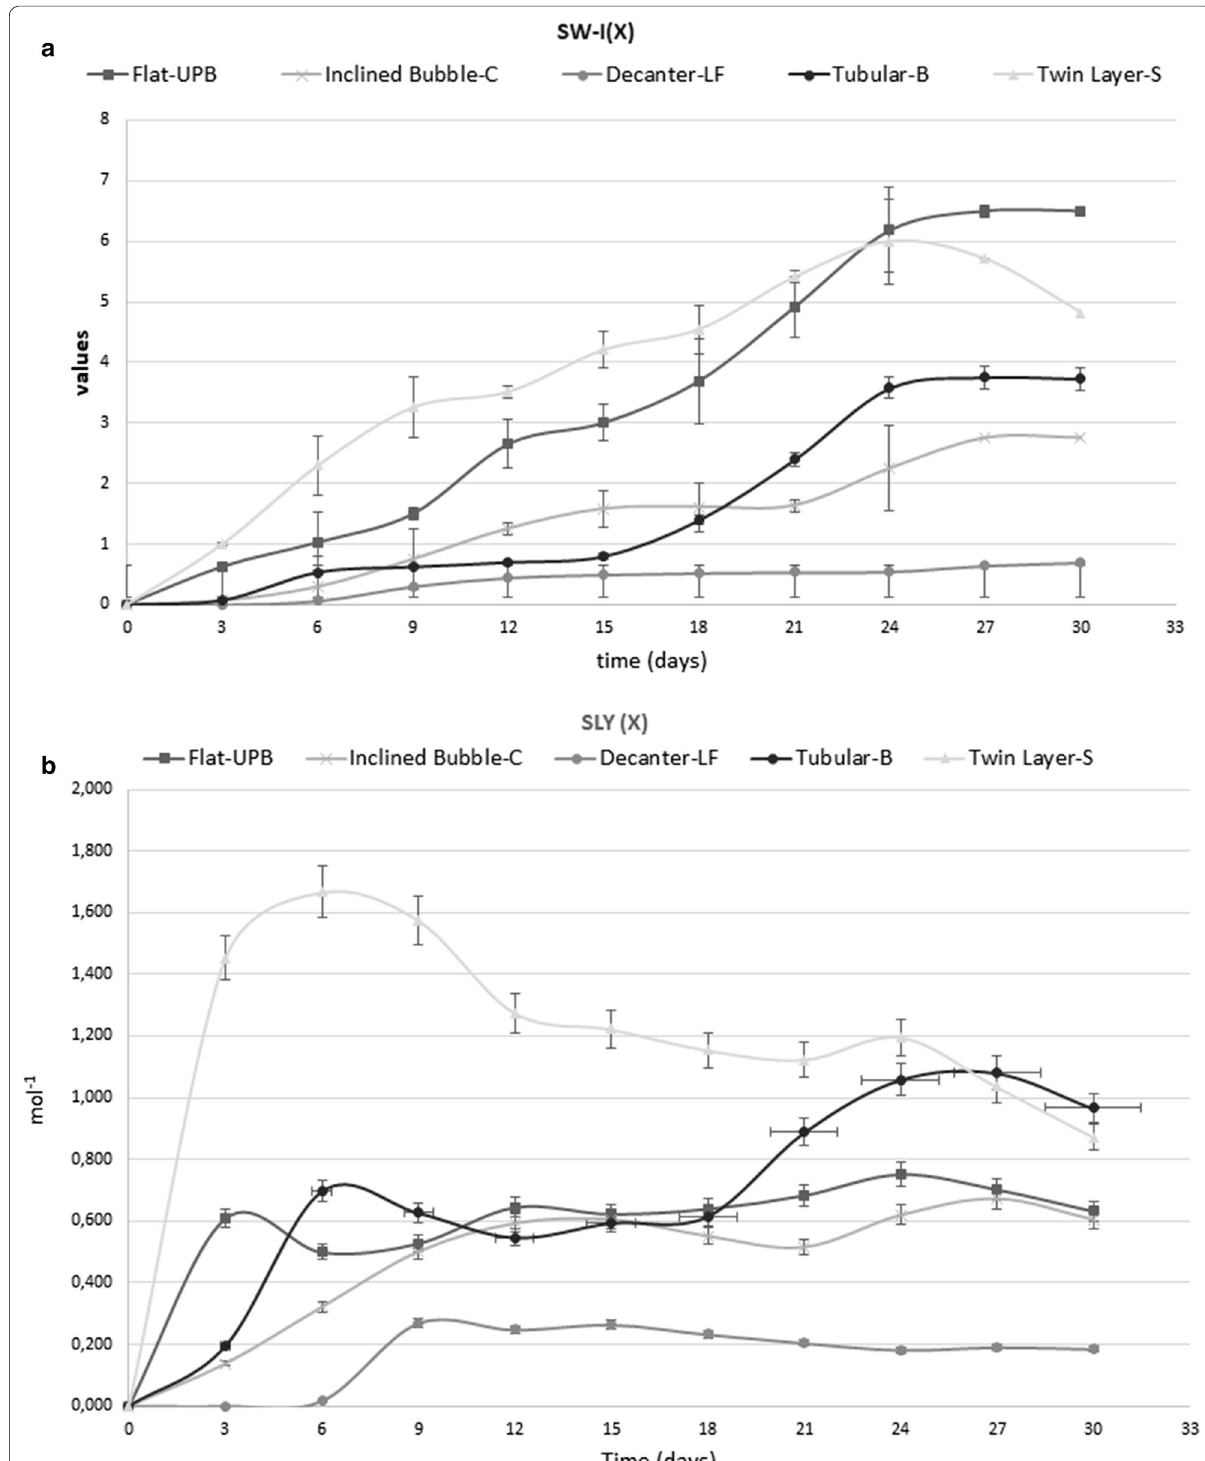
Fig. 2 a Specific weight increase (SWI) values in the different systems during 30th days. b Specific light yield (SLY) values in the different systems during 30th